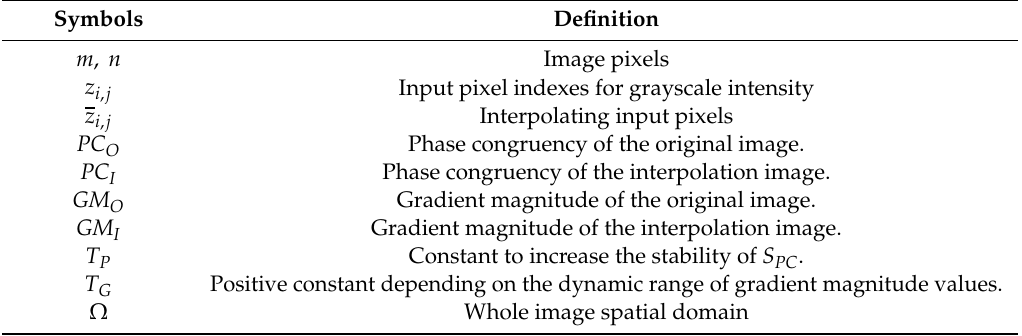
Table 4. List of